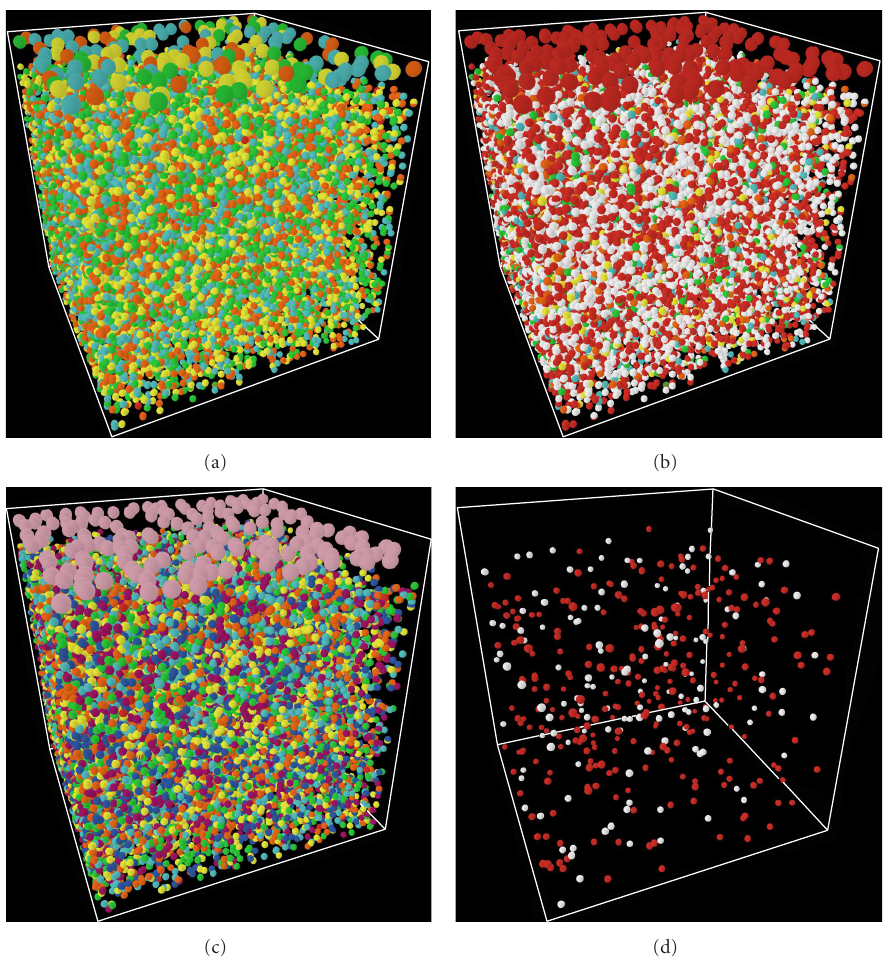
Figure 4: (a) DH network with four-colored node types, 164 enlarged hubs, and twenty seeds per type. (b) After the viruses have spread, all infected nodes are red and all susceptible isolated nodes are white. (c) Same DH network, but now with dark-pink-immunized hubs and six-colored node types. (d) Since the viruses are nearly unable to spread-there are only few red-and white-isolated nodes (other nodes not